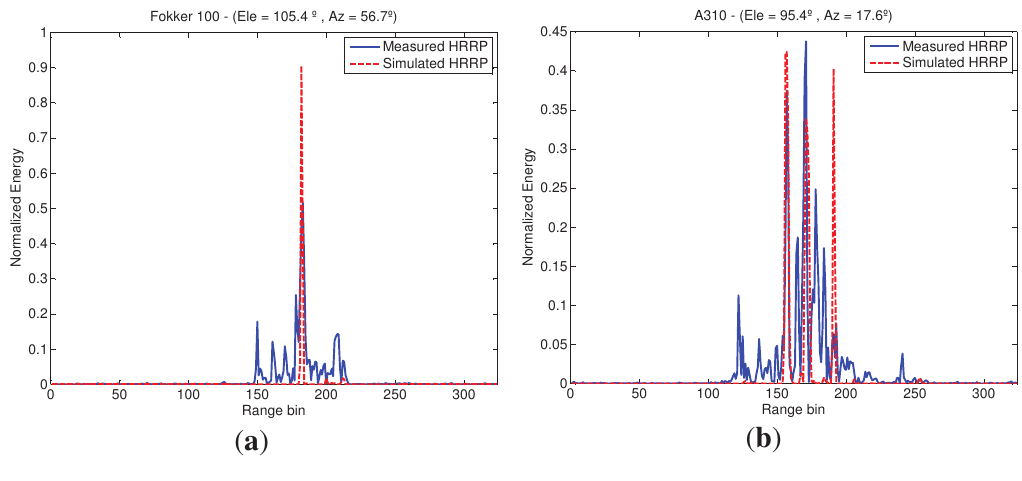
Figure 3. Difference between actual and synthetic range profiles. ( a ) Measured vs. Simulated Profile—F100; ( b ) Measured vs. Simulated